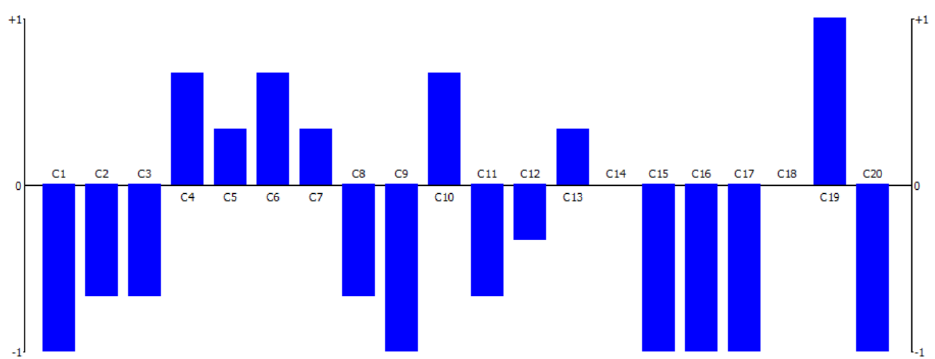
Figure 5. Scoring map of R community for resilience adapted to FFE.